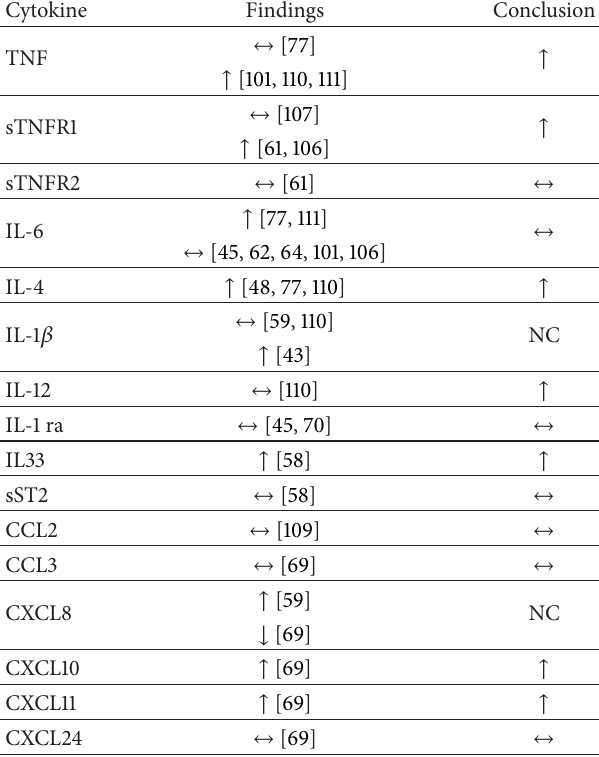
Table 2: Cytokine peripheral levels in bipolar disorder patients in mania state compared with controls.